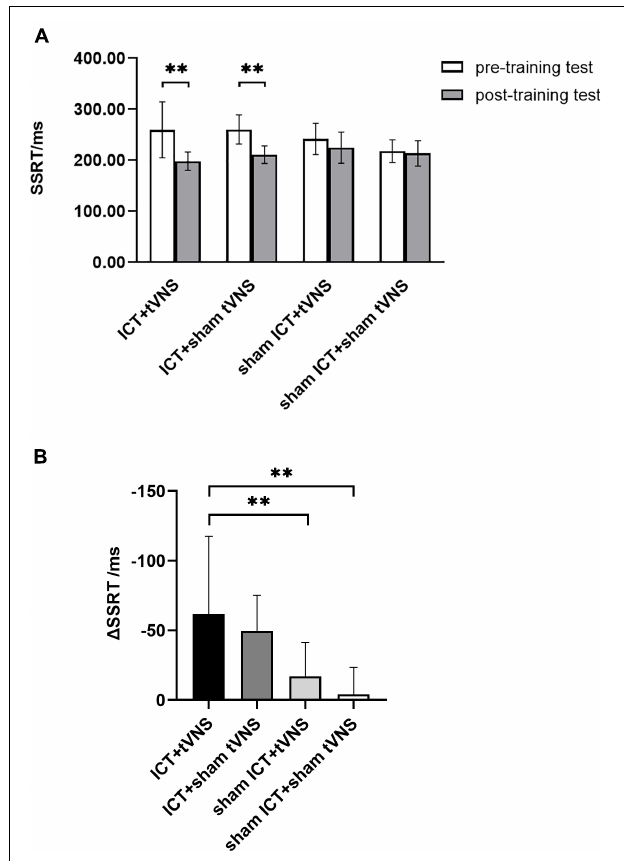
FIGURE 3 | (A) The performance of SST tests: SSRT of the SST between pre- and post-training tests. (B) The performance of SST tests: The decrement of the SSRT for each group. ∗∗ P < 0.01, Error bars represent the standard error of the mean.